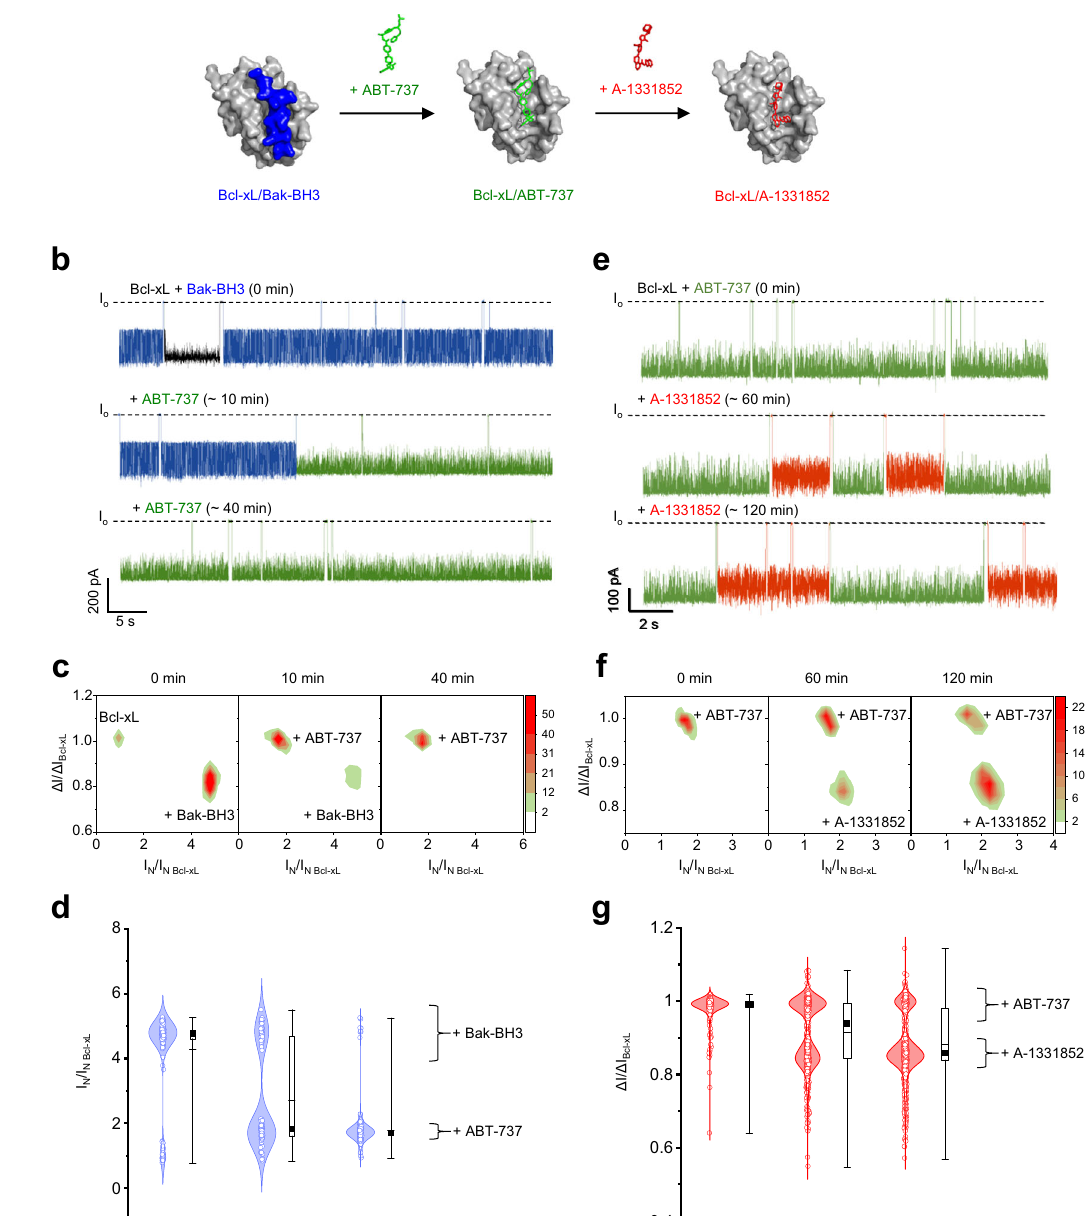
Fig.5|YaxABnanoporemeasurementsofdrugcompetitionforbindingtoBcl- xL. a Schematic illustration of small-molecule drug competition. b